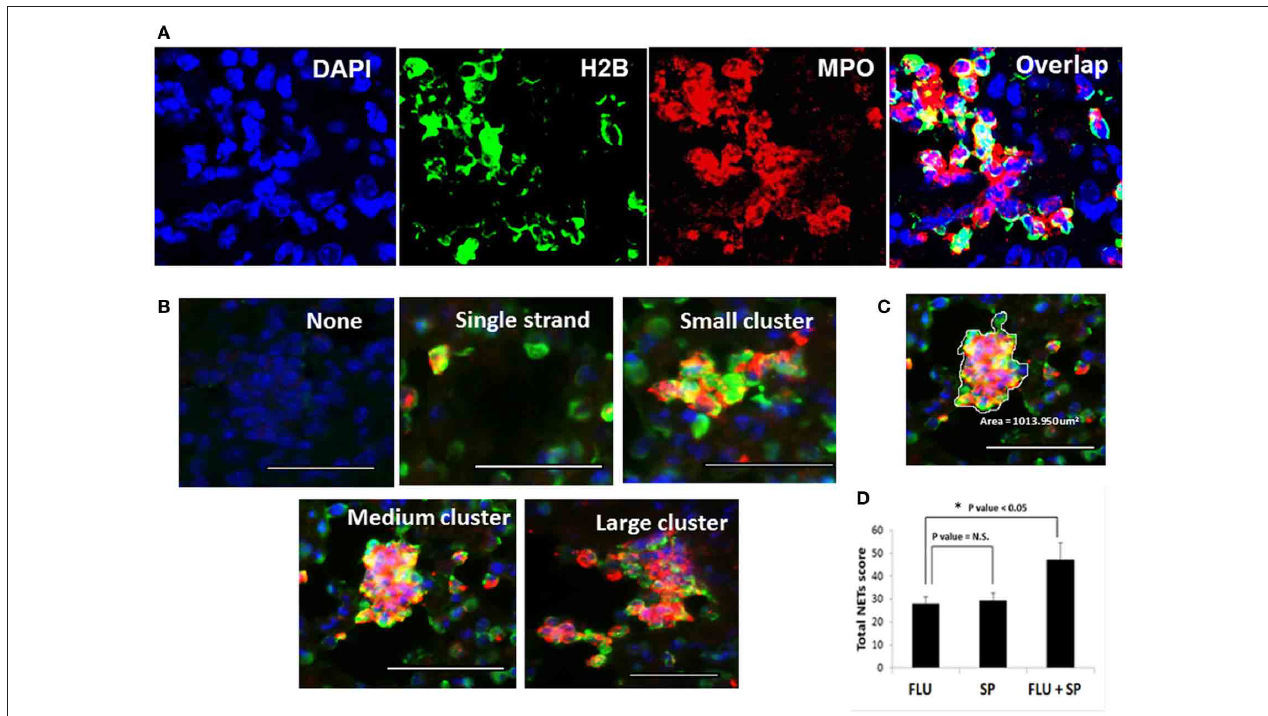
FIGURE 2 | Detection and quantification of NETs in the lungs of infected mice. Detection of NETs induced in lung tissues of mice infected with lethal doses of influenza virus followed by S. pneumoniae challenge. (A) For identification of NETs, lung sections were stained with histone H2B (green), MPO (red), and DAPI (blue). (B) NETs formation was analyzed microscopically based on triple immunostaining, and by their morphologic characteristics, i.e.,